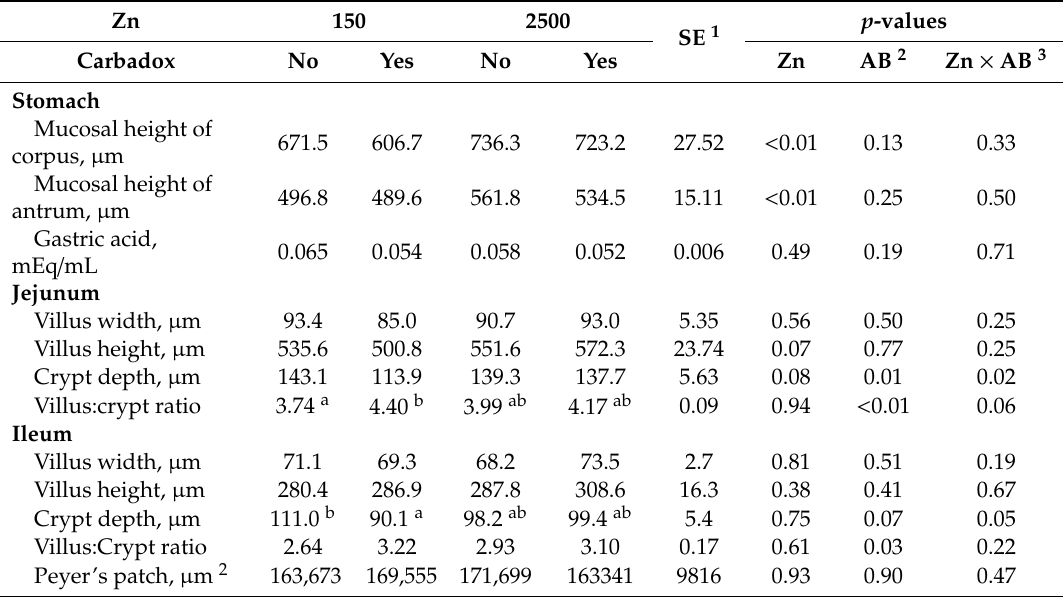
Figure 2. Representative images of gastric corpus ( A ) and antrum ( B ) stained with periodic acid–Schiff/Alcian blue and jejunum ( C ) and ileum ( D ) stained with hematoxylin and eosin (H&E). Scale bar: 100 µm. Table 1. Gastric acid production and gastrointestinal (GI) morphology of post-weaning pigs fed diets containing a pharmacological dose of Zn and